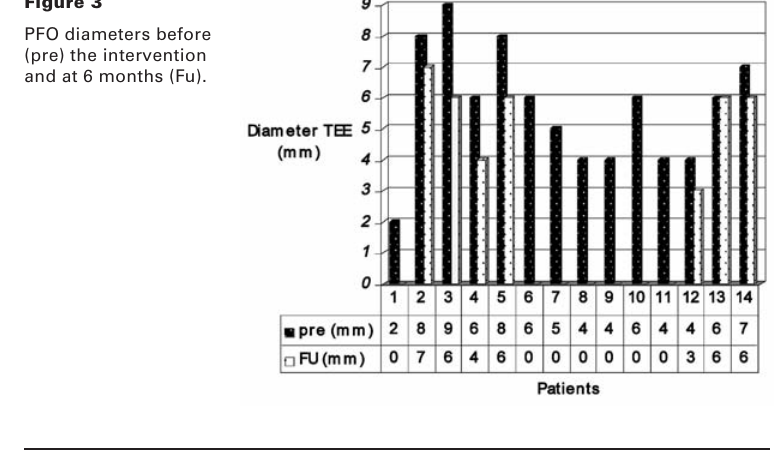
Figure 4 Power M-mode trans - cranial Doppler device microemboli signals before (pre) the intervention and at 6 months (Fu).